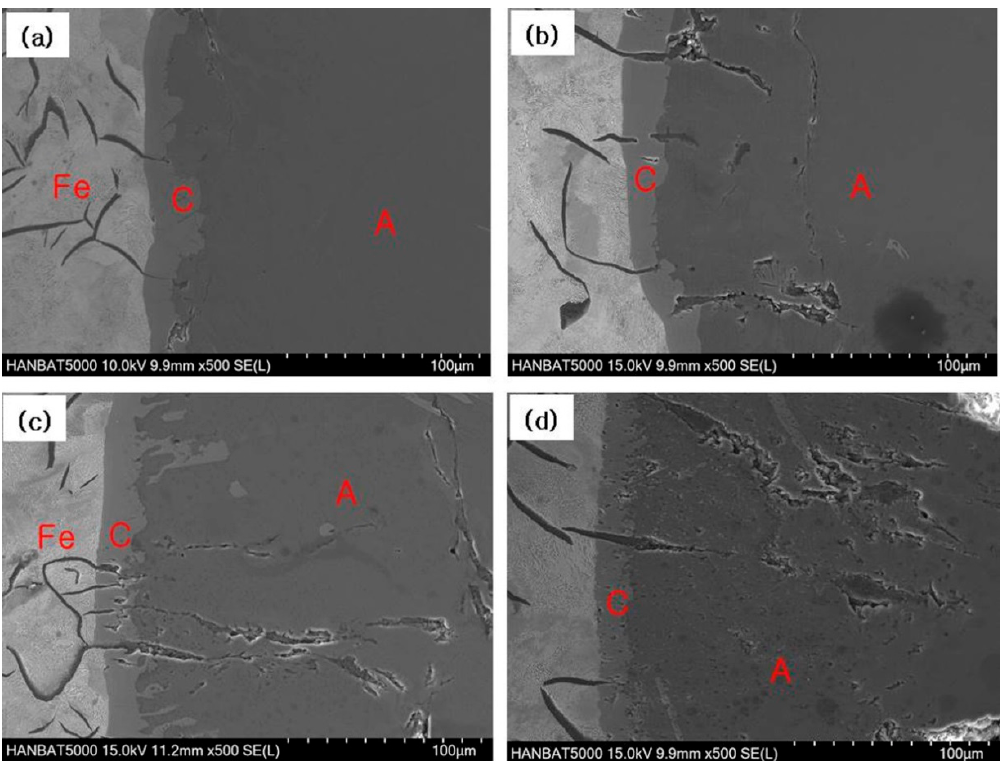
Figure 6. SEM-EDS analysis of cast iron/liquid Al–Si alloy interface isothermally heated at 720 °C for different times: ( a ) 0 min, ( b ) 1 min, ( c ) 5 min, ( d ) 10 min (C refers to the interfacial compound region and A refers to the aluminum base region near the interface in Table 3).